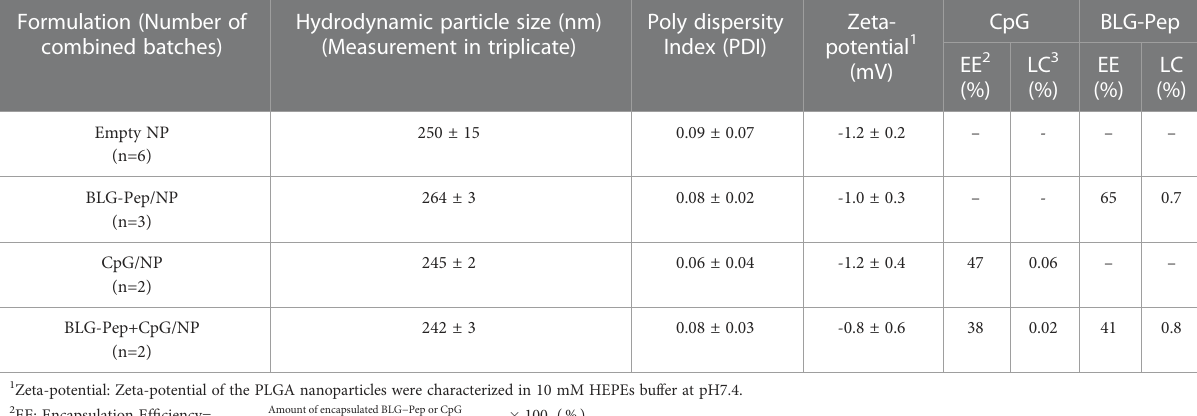
TABLE 2 Characteristics of BLG-Pep and/or CpG encapsulated PLGA nanoparticles. Formulation (Number of combined